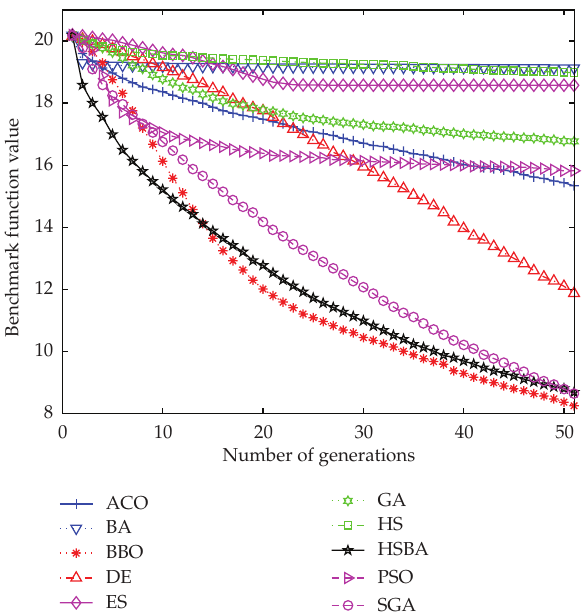
Figure 1: Comparison of the performance of the different methods for the F01 Ackley function.